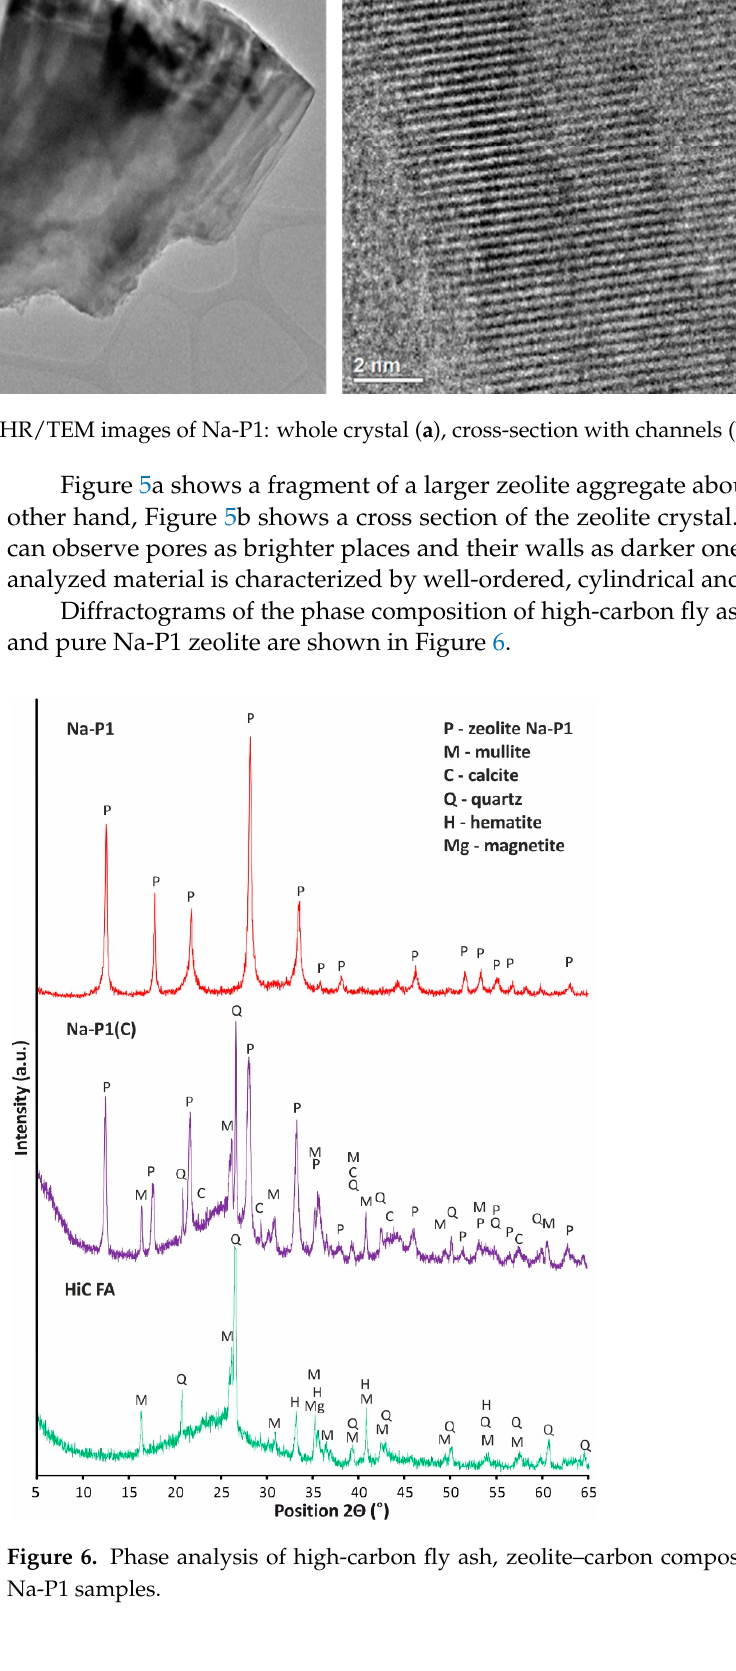
Figure 6. Phase analysis of high ‐ carbon fly ash, zeolite–carbon composite Na ‐ P1(C) and zeolite Na ‐ P1 samples.